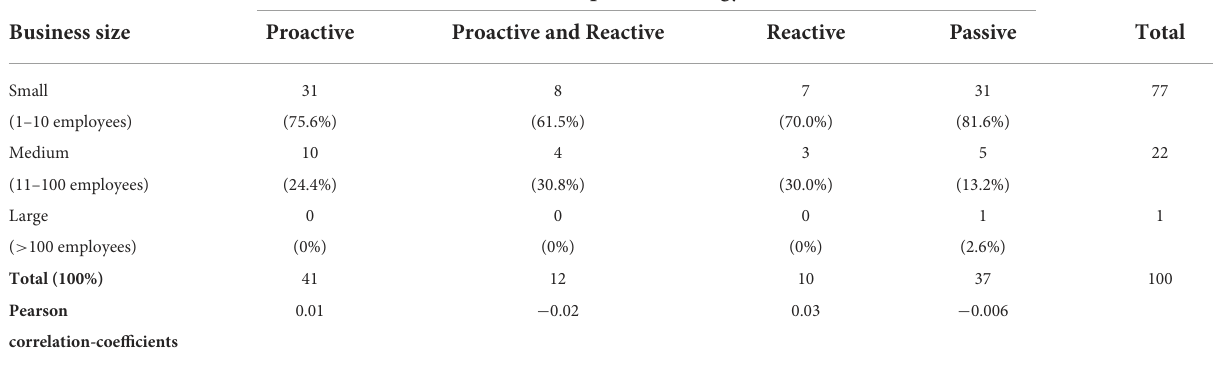
TABLE 7 Distribution of business size with class division of the number of employees and Pearson correlation coefficient without class division of the number of employees ( n = 100, data: businesses in Germany damaged by pluvial floods 2014-2017). Adaptation Strategy